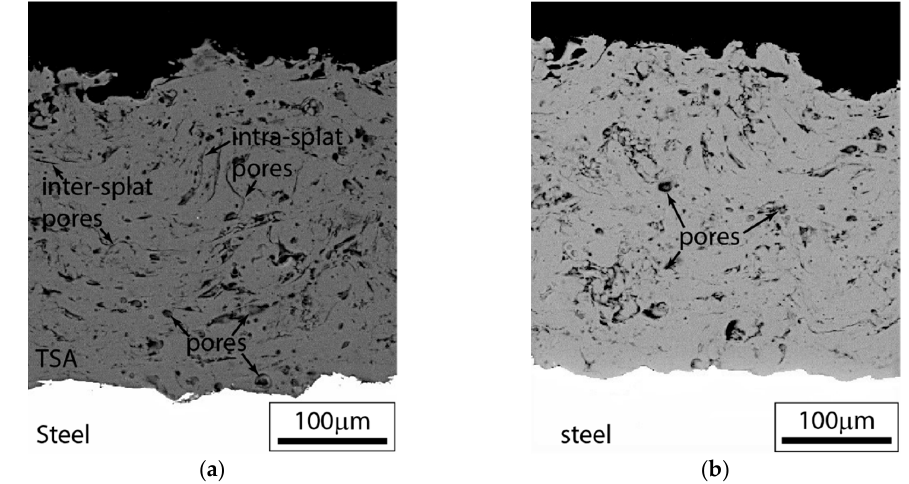
Figure 5. Micrographs of ( a ) TSA-coated X80 steel and ( b ) TSA-coated AISI 4137 showing the as-sprayed coating (cross-section) microstructure before testing.